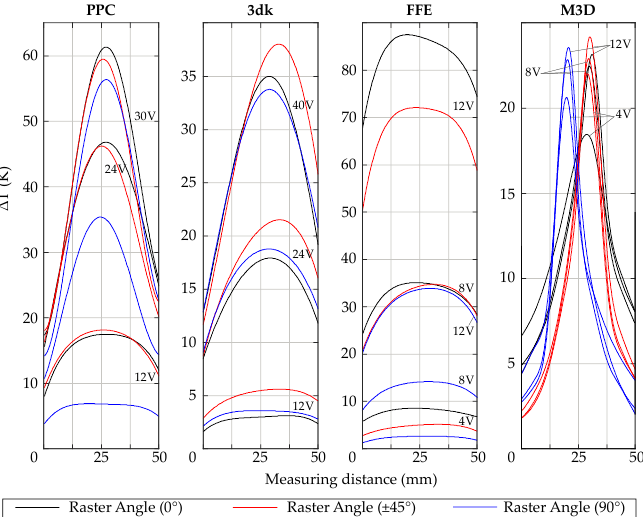
Figure 14. Heat distribution of the investigated materials along the specimen for material-specific voltages and the raster angle orientations of 0°, ±45° and 45° respectively.